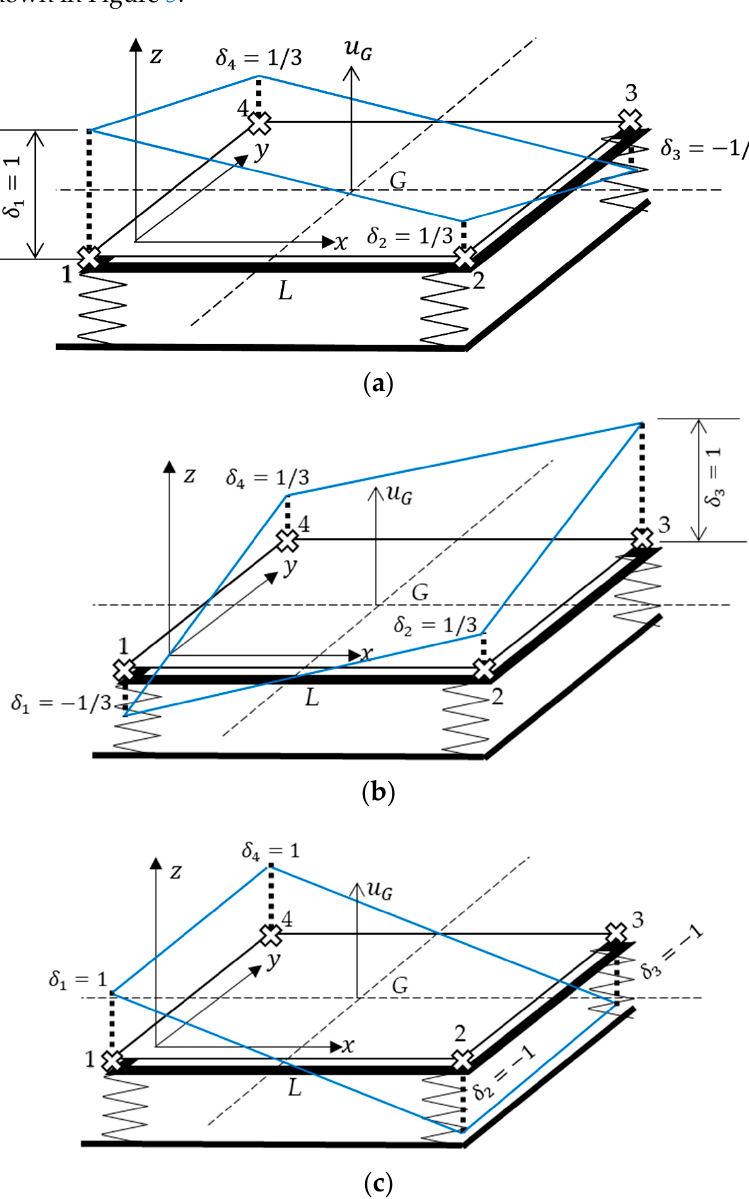
Figure 5. Analytically obtained natural frequencies: ( a ) Mode 1, ( b ) Mode 2, and ( c ) Mode